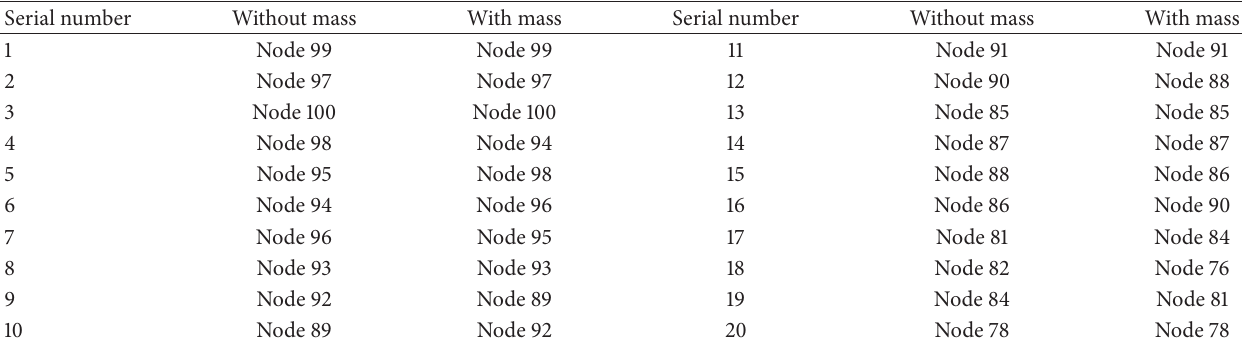
Table 3: The top 20 nodes of the artificial complex